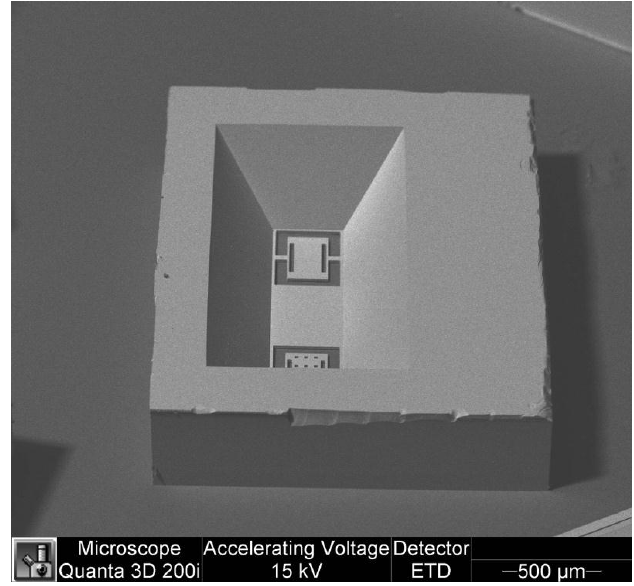
Figure 2. SEM image of a die reverse-side with two silicon structures which were etched using the KOH in bulk micromachining process. (Courtesy of A. L. Herrera-May, Universidad